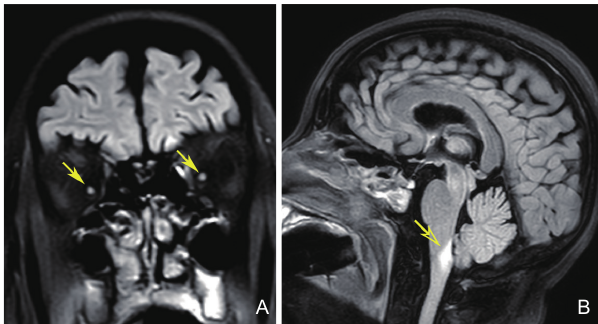
Figure 3 Coronal and sagittal T2 fluid attenuated inversion recovery imaging demonstrated the high signal on the bilateral optic nerves (solid arrows) and area postrema (empty arrow),